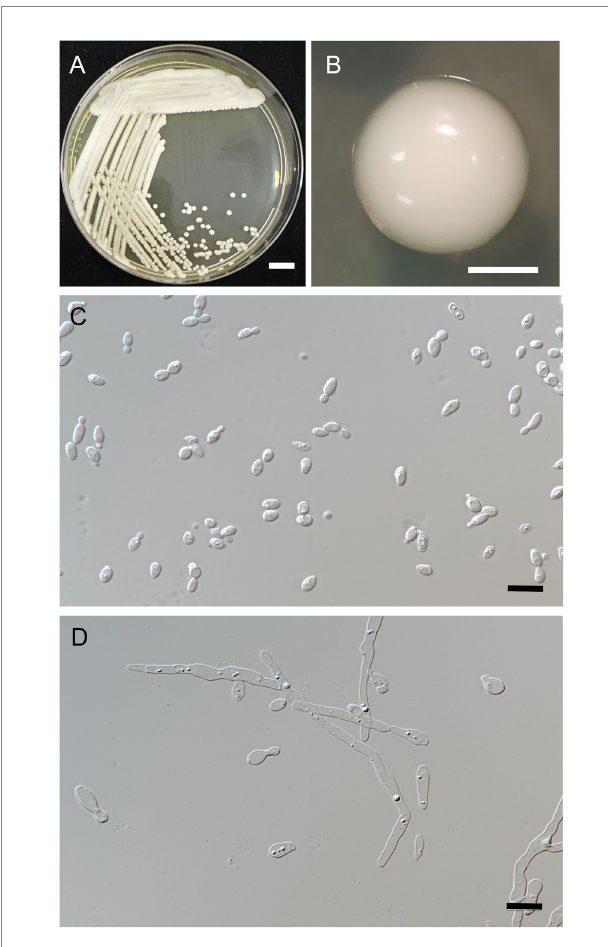
FIGURE 4 Metschnikowia lannaensis FLA8.2 T (=SDBR-CMU426 T , holotype). Culture (A) , single colony (B) , and cells (C) on YMA after incubation at 25 ° C for 3 days. Pseudohyphae (D) on PDA after incubation at 25 ° C for 4 weeks. Scale bar A = 1 cm, B = 1 mm, and C and D = 10 μ m.